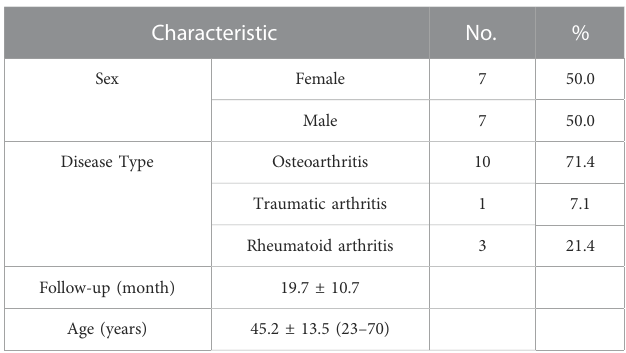
TABLE 1 General information ( n = 14).